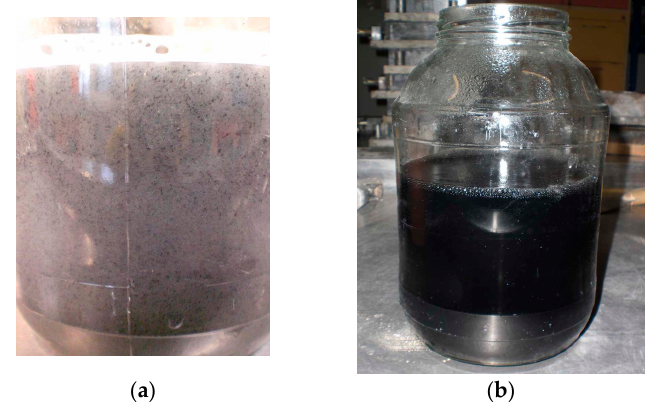
Figure 3. The CNT water suspension: ( a ) before sonication—visible clusters of CNT in the form of “lumps”; ( b ) after sonication—uniform color of the suspension, which indirectly correspond to a uniform CNT dispersion.